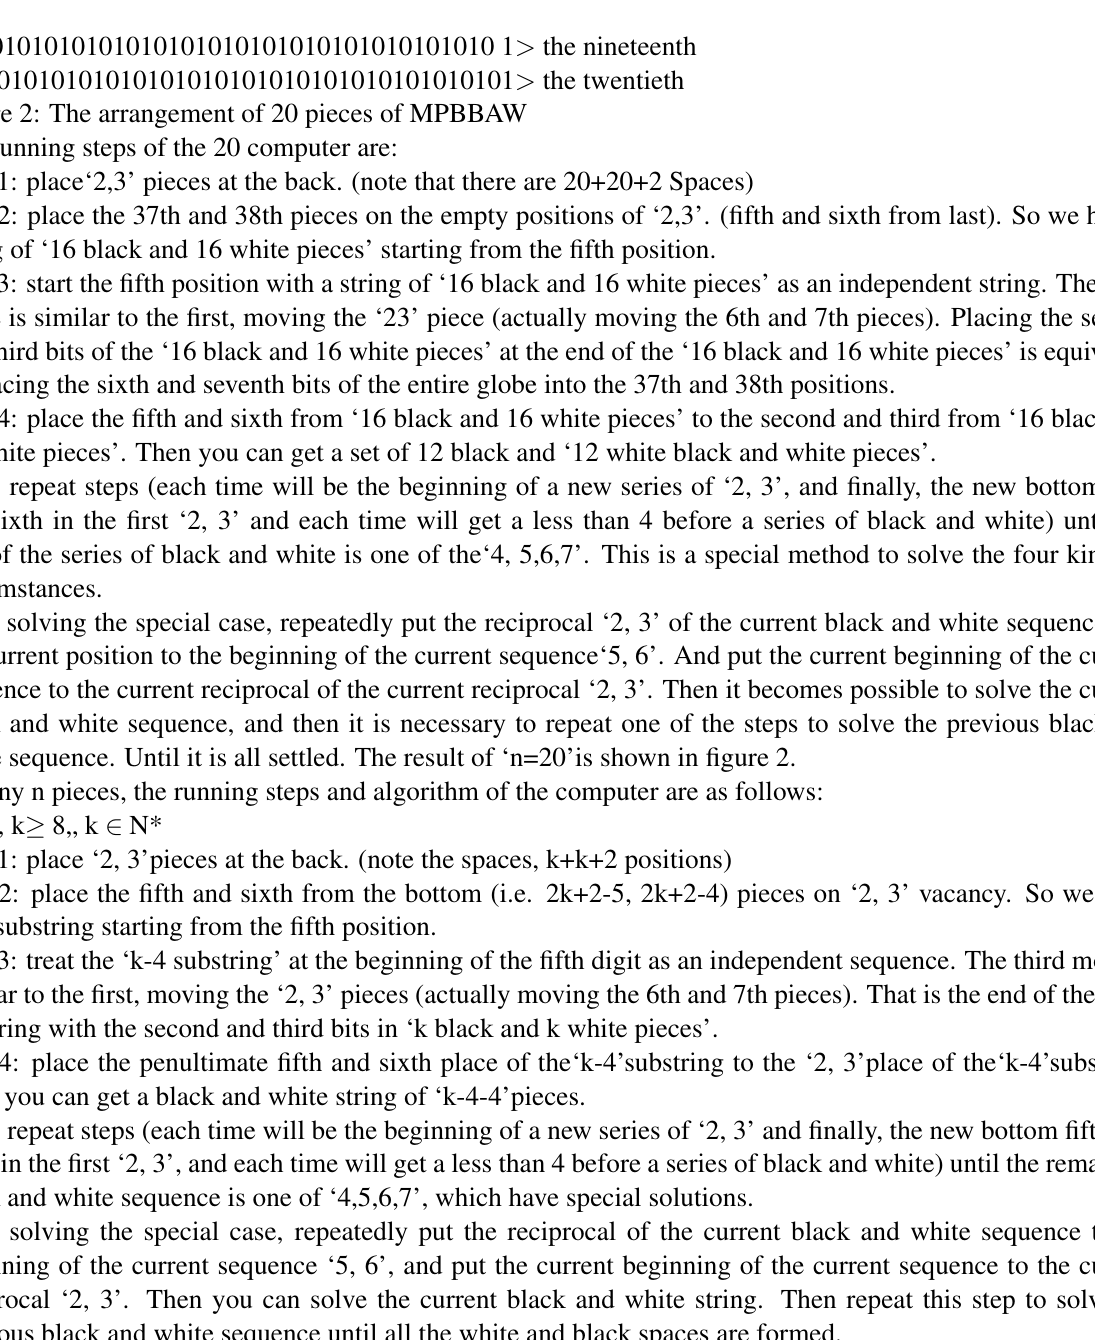
Figure 2: The arrangement of 20 pieces of